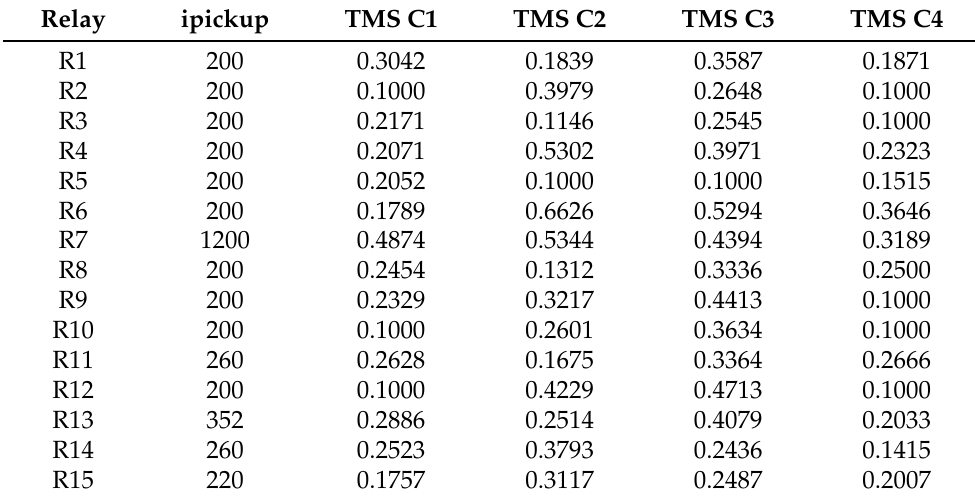
Table 5. Coordination adjustments with K-means